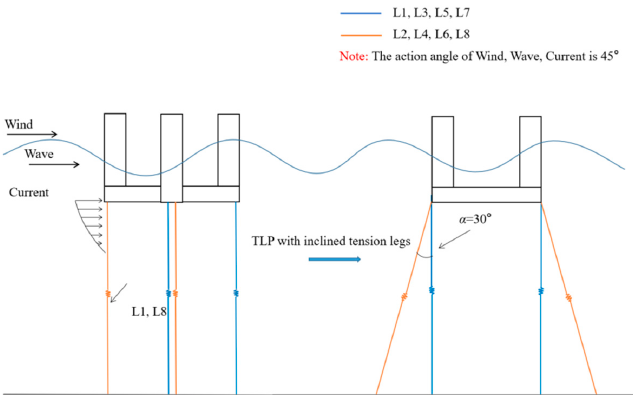
Figure 6. Inclined angle of tension legs and the acting direction of the wind, wave, and current.